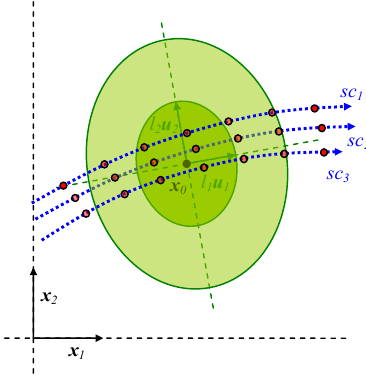
Fig. 4. If the spacecraft sample the homogeneity domain only par- tially, for instance only along homogeneity direction u 1 as sketched in this example, the residuals do not contain any information about the approximation error along the other directions so that the corre- sponding homogeneity lengths cannot be